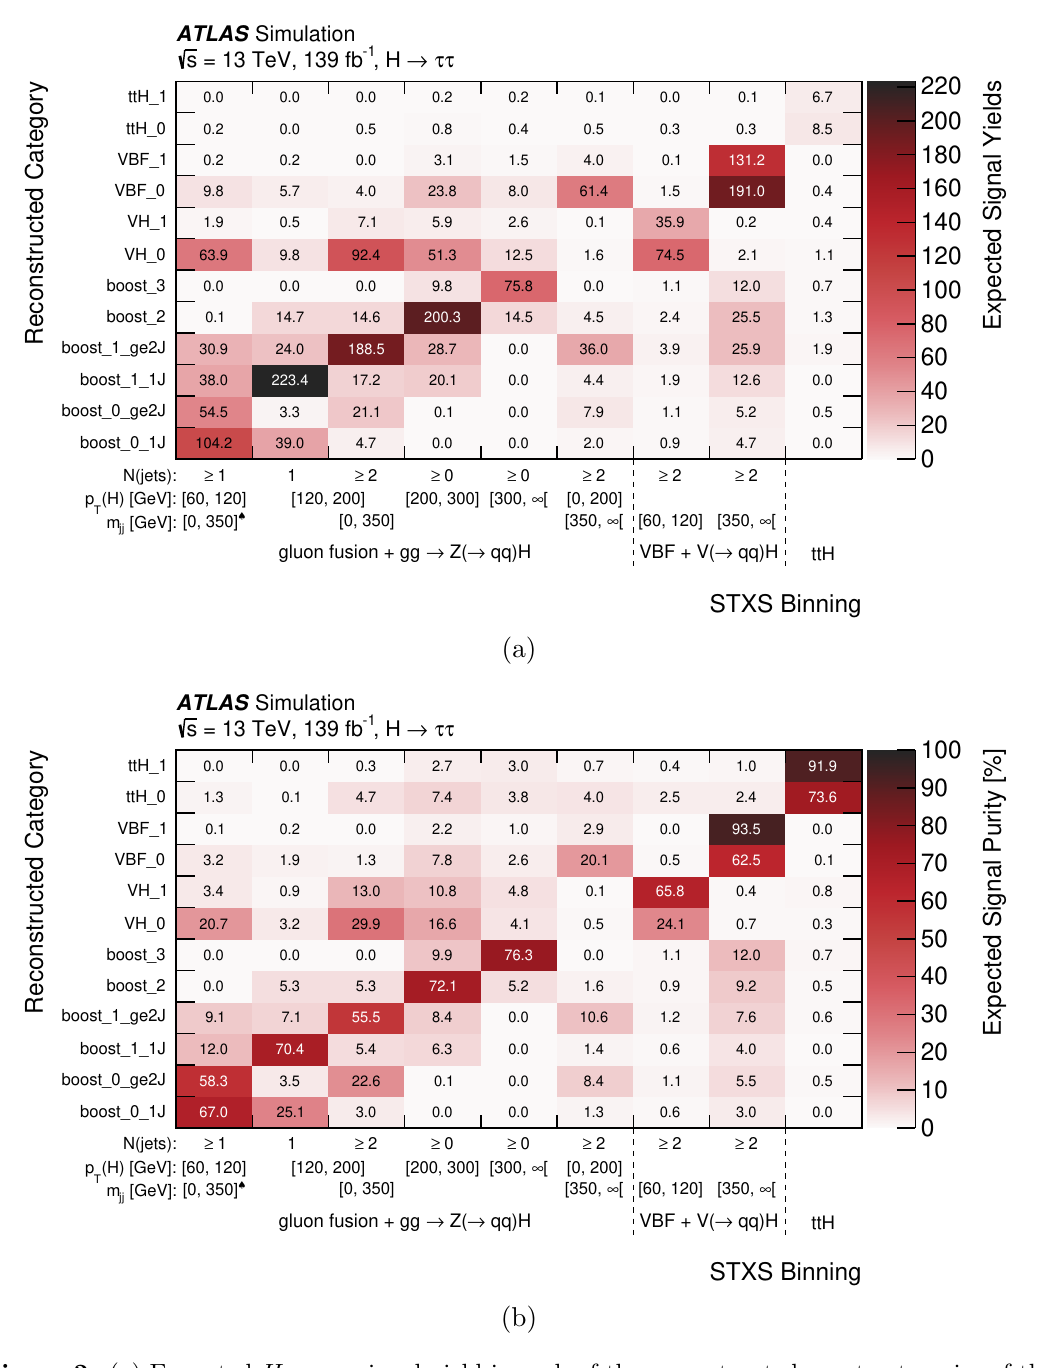
only apply to events with at least jj τ , τ τ , τ τ e µ lep had had had